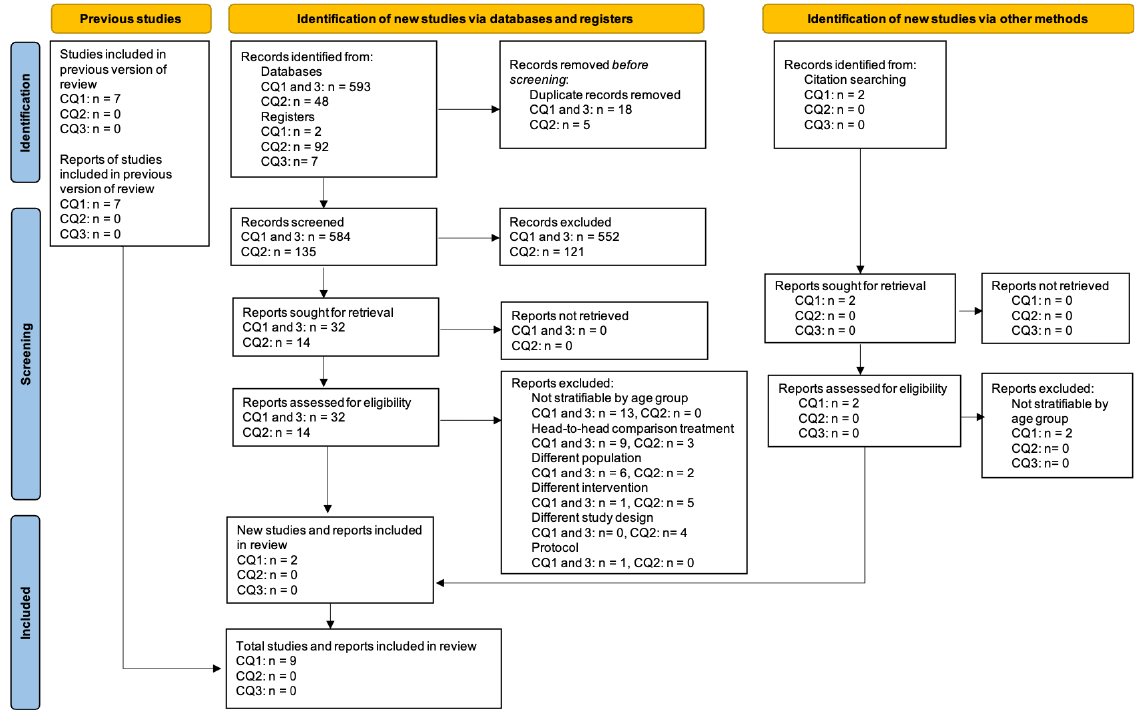
Figure 1. PRISMA flow diagram for review questions Q1 – Q3 .